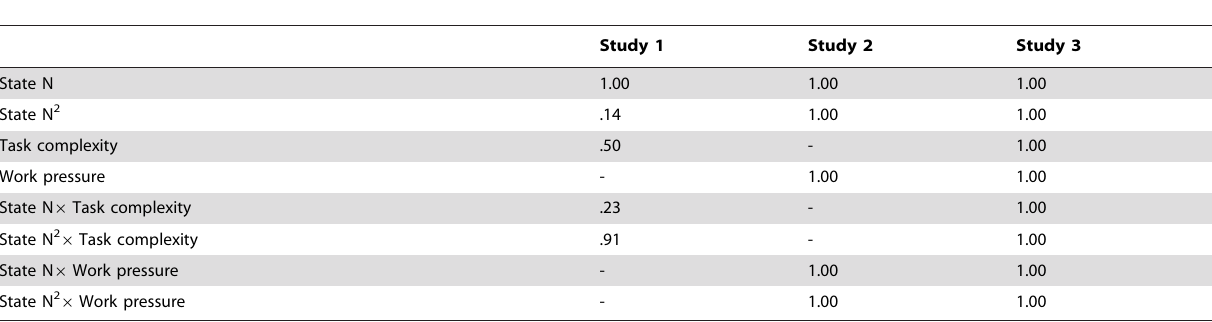
Table 7. Post-hoc power calculations for all three studies, using the